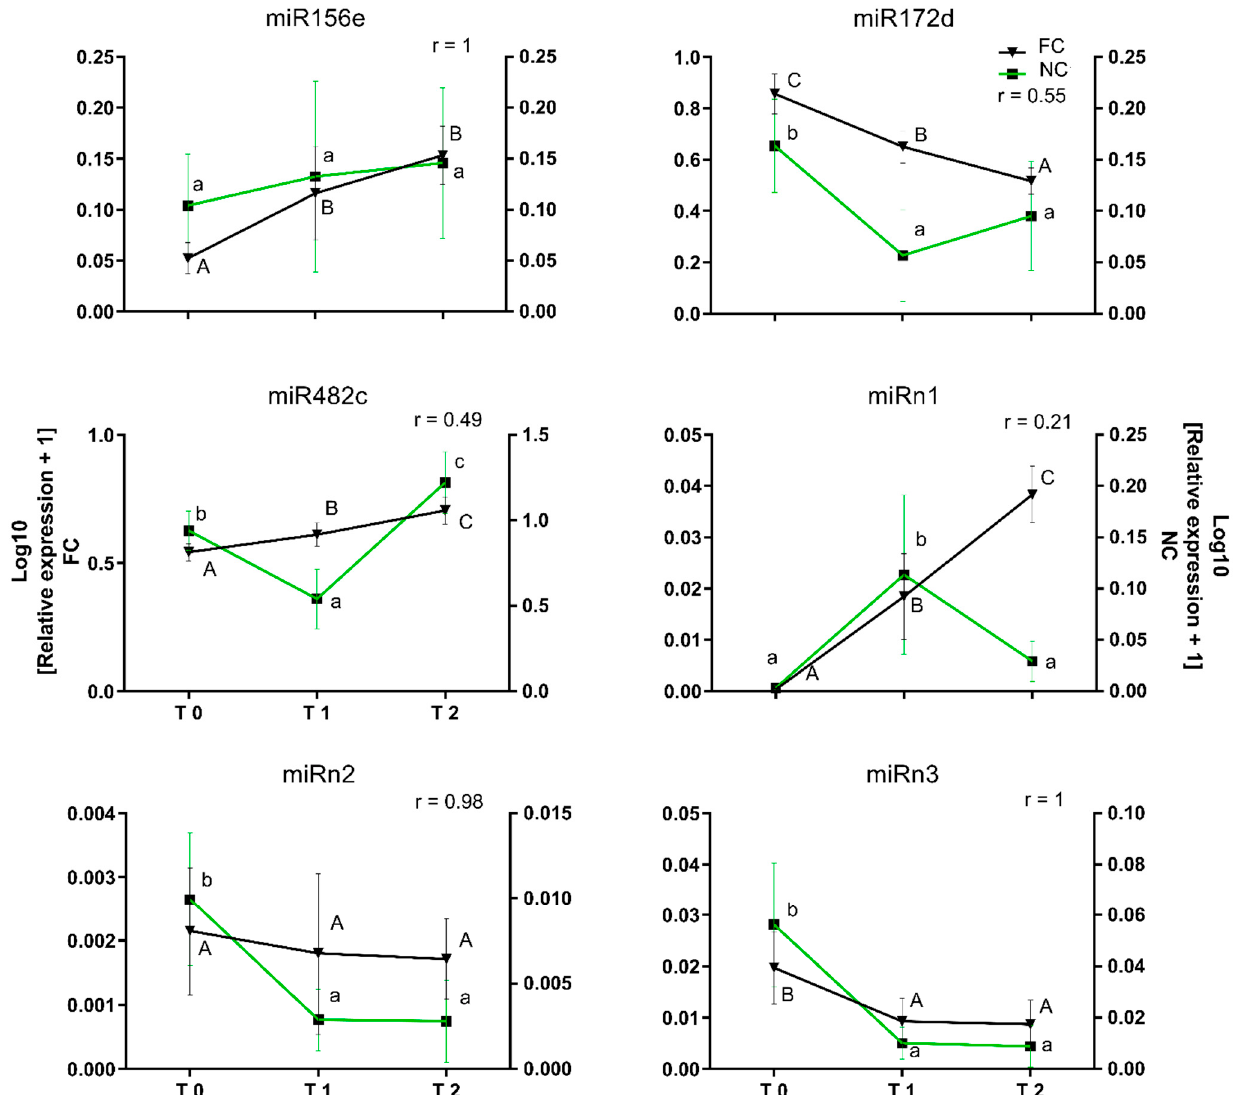
Figure 5. Comparison of the relative expression of miRNAs in floral buds from field chilling (FC) and non-stop chilling (NC) conditions. Floral buds were obtained from trees subjected to natural cold accumulation in the field (FC) and from sticks subjected to continuous chilling under cold storage (NC) conditions. sRNAs were isolated, and expression levels of miRNAs were determined by qRT-PCR. Means with different letters among stages are significantly different ( p -value ≤ 0.05). Pearson’s correlation (r) was determined between the relative expression levels in both seasons. Black line shows FC relative expression and green line shows NC relative expression.